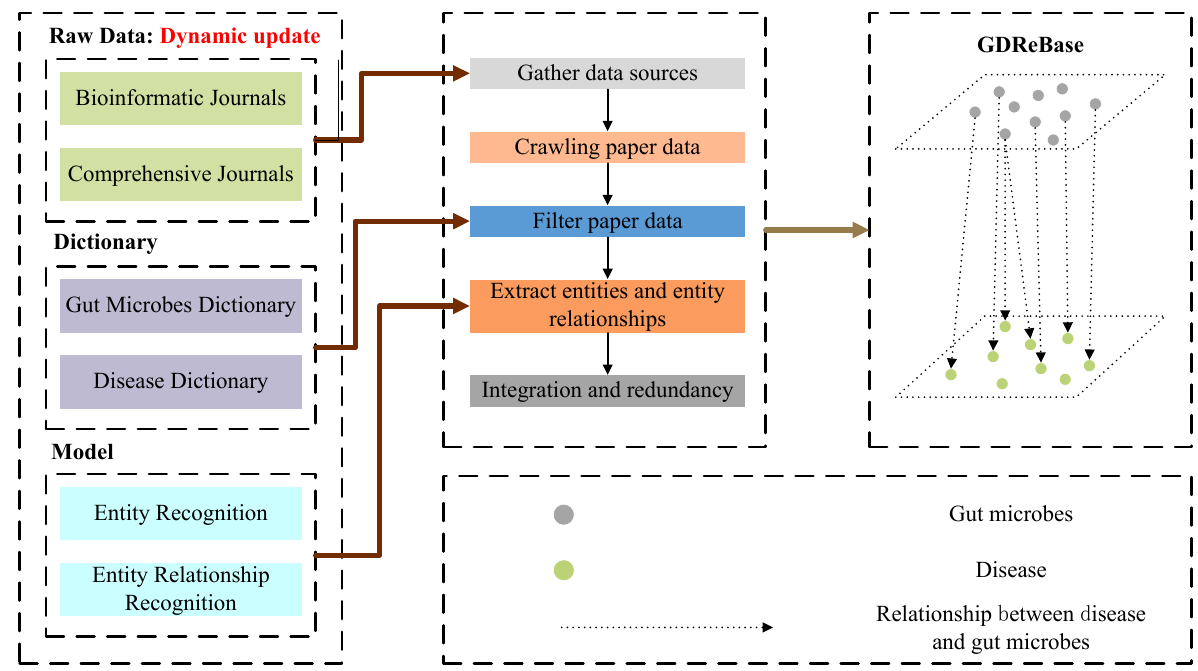
Figure 4. The schematic flow of the GDReBase construction.